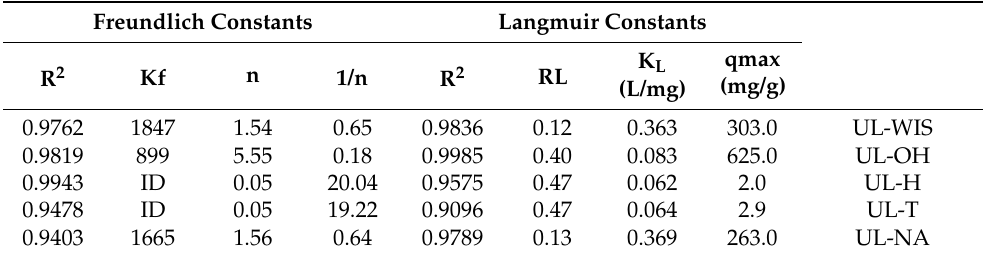
Table 6. Langmuir and Freundlich constants for